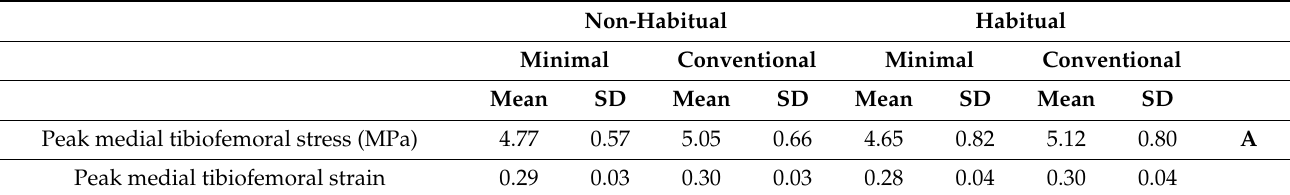
Table 5. Stress/strain parameters.